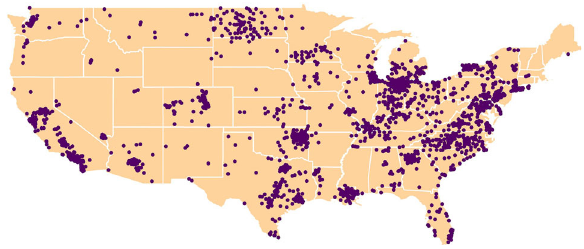
FIG. 1. Map of the home ZIP codes of student respondents. Note that each dot represents a ZIP code, not a student, so each dot may contain more than one